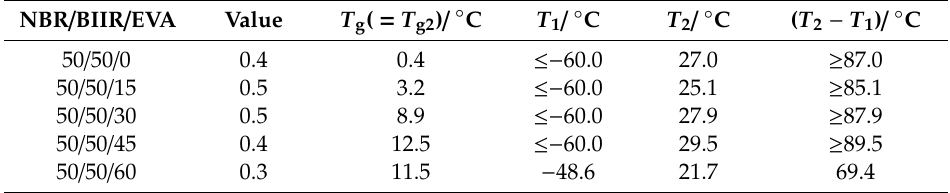
Table 6 . Damping property parameters of NBR/BIIR/EVA with various blend ratios. NBR/BIIR/EVA